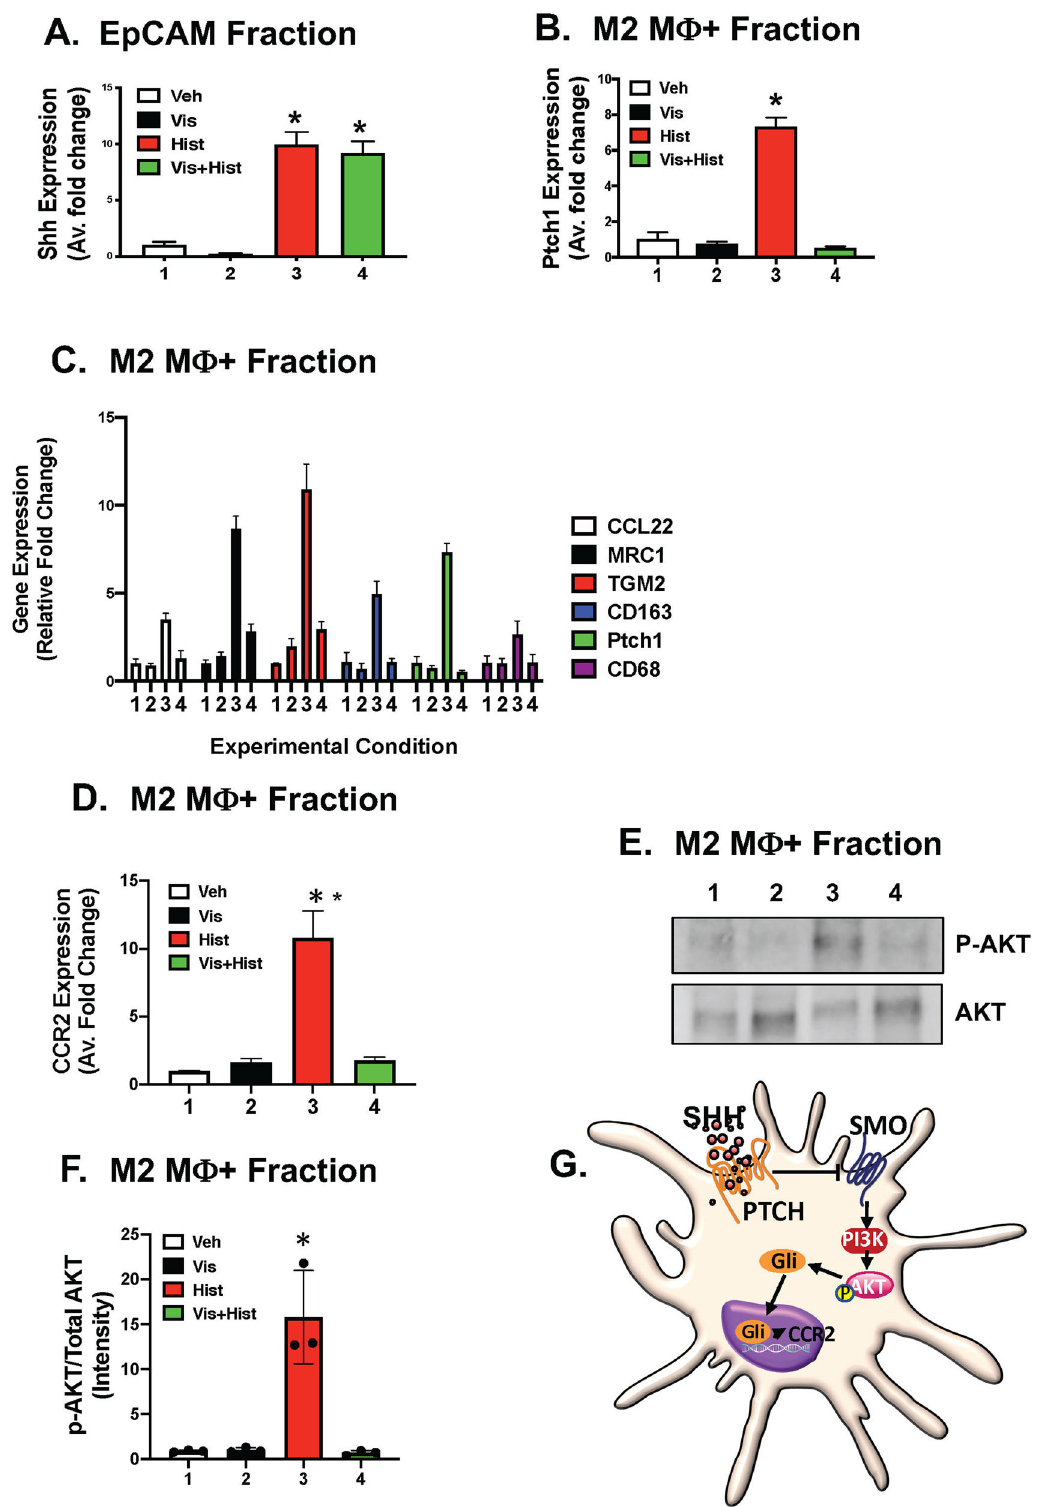
Fig. 7 Expression of Shh, Ptch1, CCR2, and M1/M2 macrophage markers in organoid/macrophage co-cultures. A Expression of Shh in EpCAM fractions isolated from vehicle (Veh, 1), vismodegib (Vis, 2), Histamine (Hist, 3), or Vis + Hist (4) treated co-cultures. B Expression of Ptch1 in M Φ fractions isolated from Veh, Vis, Hist, or Vis + Hist treated co-cultures. C Expression of M1 and M2 markers in M Φ fractions isolated from Veh, Vis, Hist, or Vis + Hist treated co-cultures. D Expression of CCR2 in M Φ fractions isolated from Veh, Vis, Hist, or Vis + Hist treated co- cultures. E Protein expression of AKT and pAKT in M Φ fractions isolated from Veh, Vis, Hist, or Vis + Hist treated co-cultures. Quanti fi cation of immunoblots in E is shown in ( F ) . G Schematic diagram showing Shh-induced macrophage migration that is Smo-dependent is mediated by AKT signaling. * P < 0.05 compared to vehicle. Data are shown as the mean ±